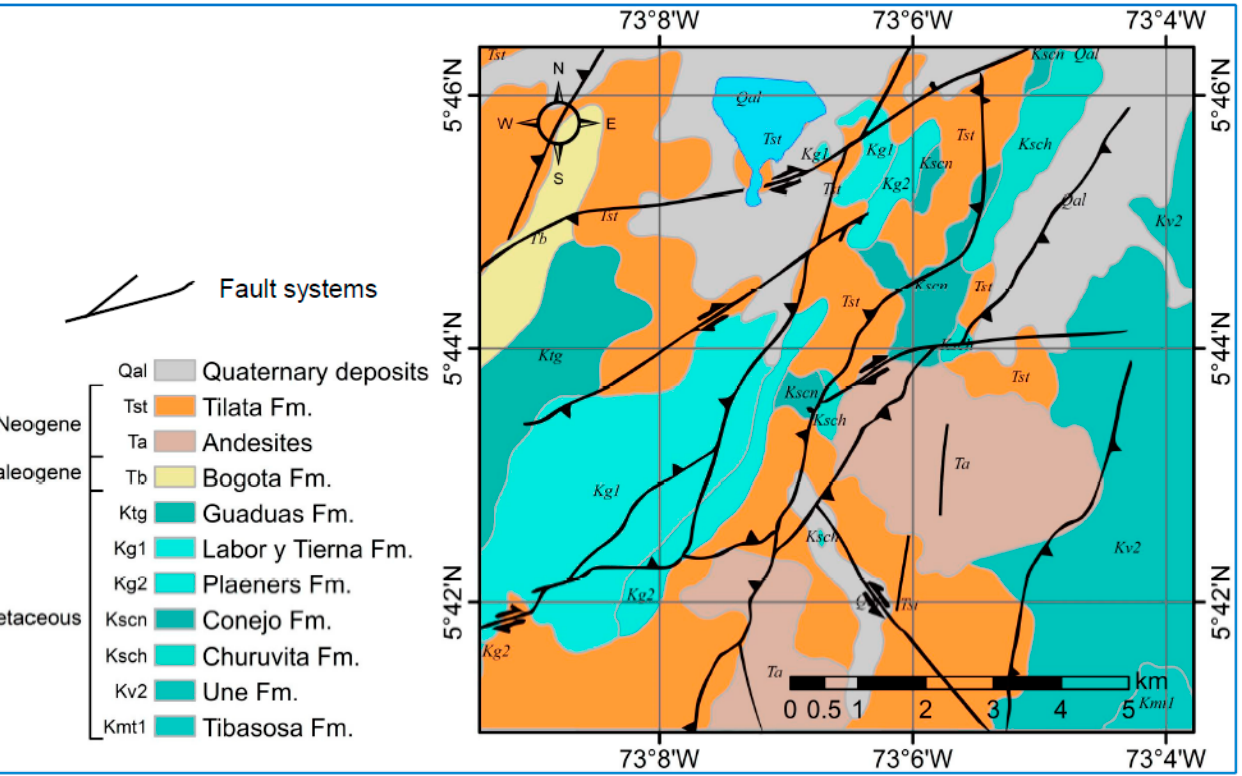
Figure 2. Map of the main geological outcropping and the principal fault system of the Paipa volcanic area related to the Sochagota Lake. Modified from [17].